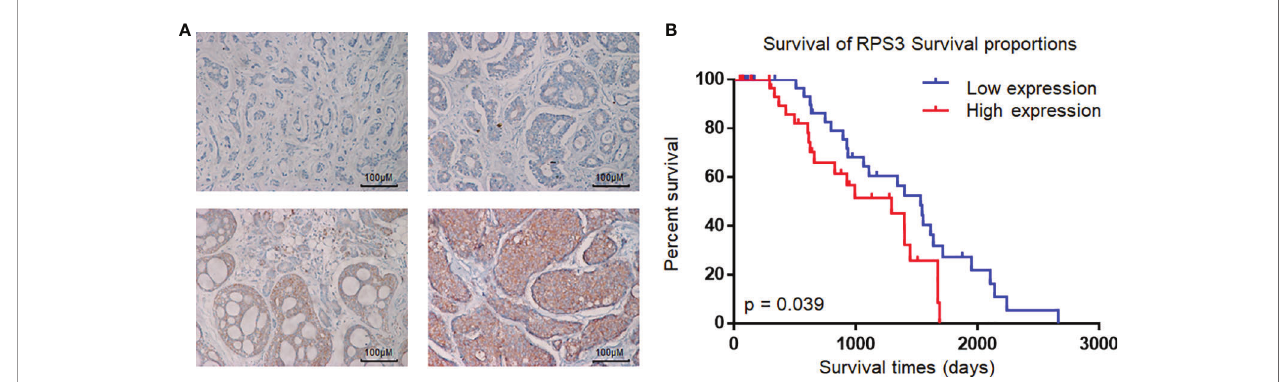
FIGURE 1 | Expression of RPS3 in ACC and analysis of pathological sections. (A) IHC scoring criteria: the staining intensity scores were 0 (negative), 1 (weak), 2 (medium), and 3 (strong). (B) Kaplan-Meier estimates of the overall survival of ACC patients based on RPS3 expression and